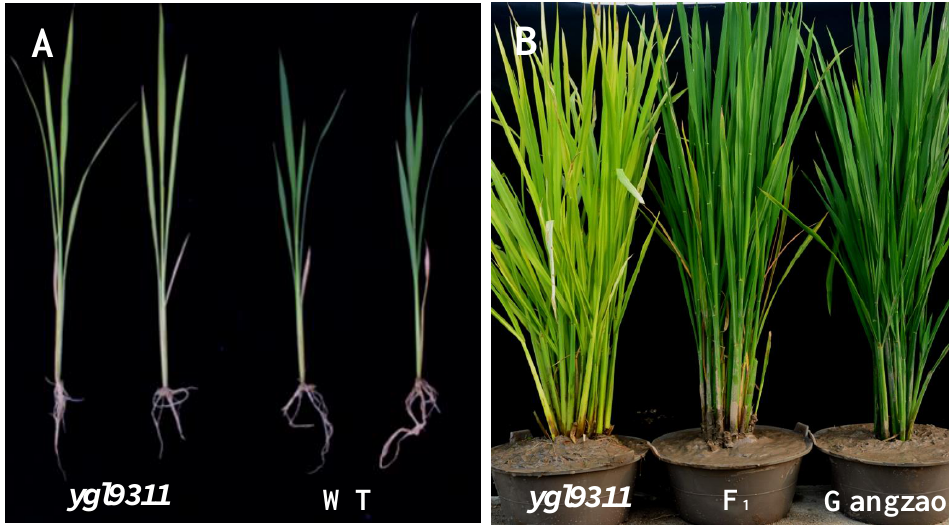
Figure 1. Phenotypic characterization of the mutant ygl9311 . ( A ) Plants at seedling stage. ( B ) Plants at mature stage grown in Hainan.